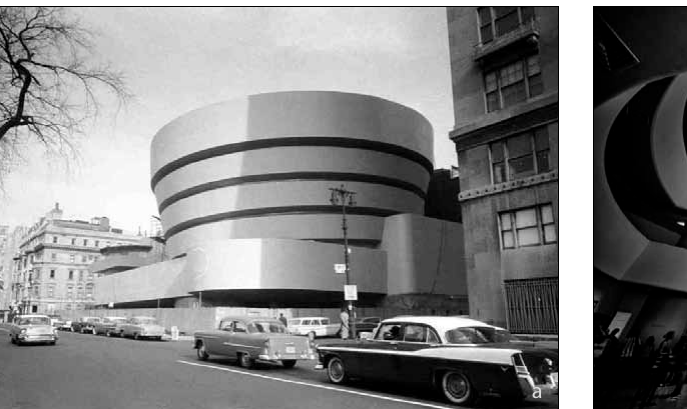
fig. 2. Guggenheim Museum, new